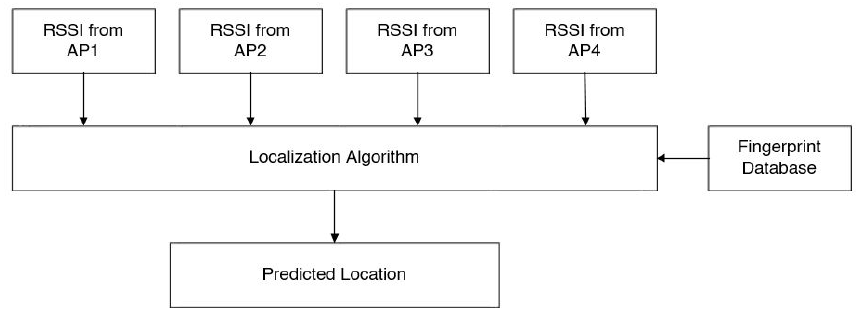
Figure 4. Location estimation procedure.